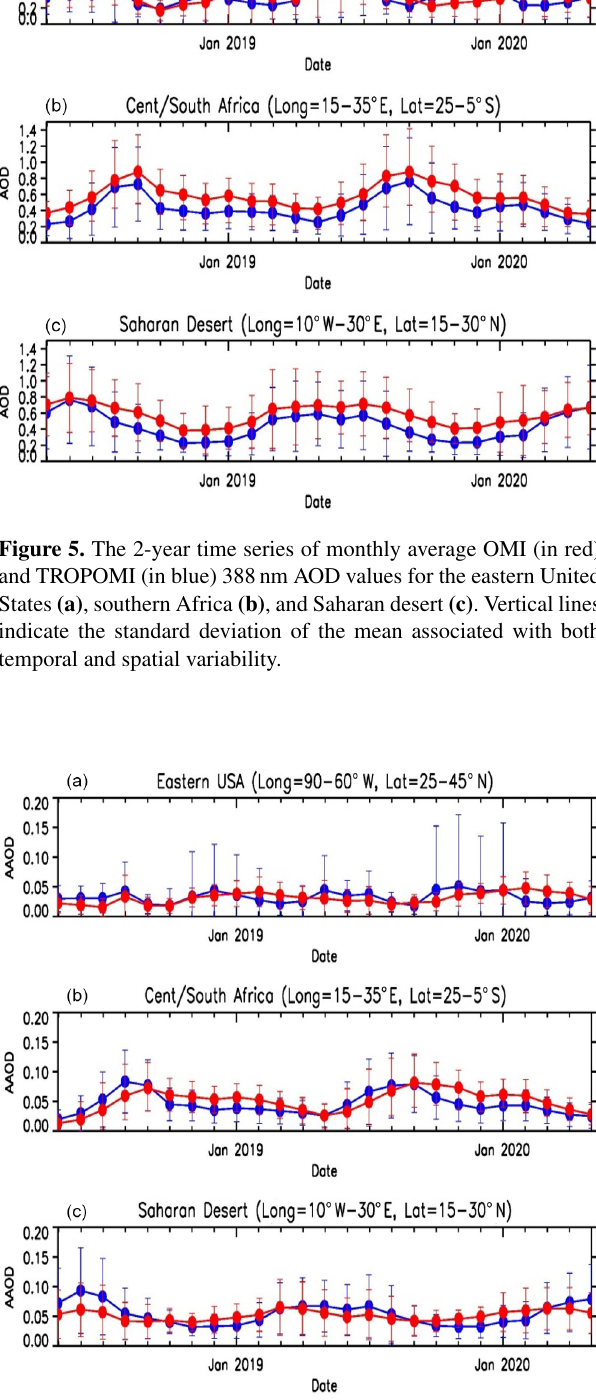
Figure 6. As in Fig. 5 for 388nm